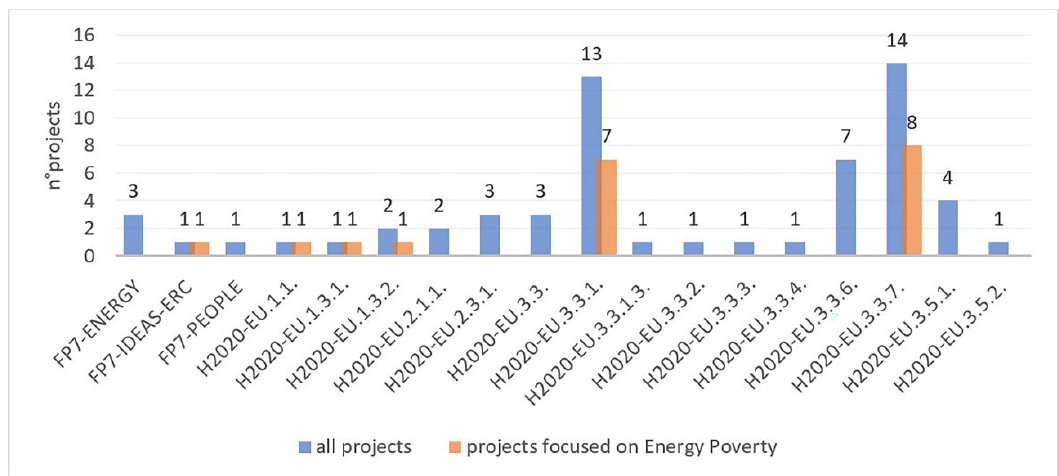
Figure 3. Number of projects per funding program. Image elaborated by the